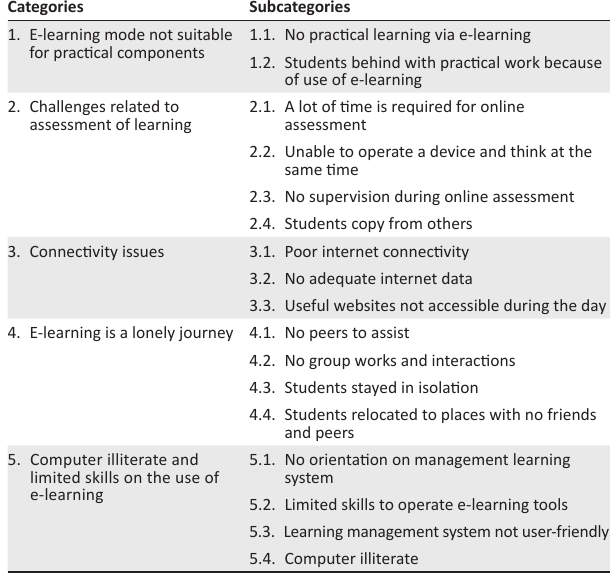
FIGURE 1: Summary of study results. TABLE 1: Categories and subcategories as results of the